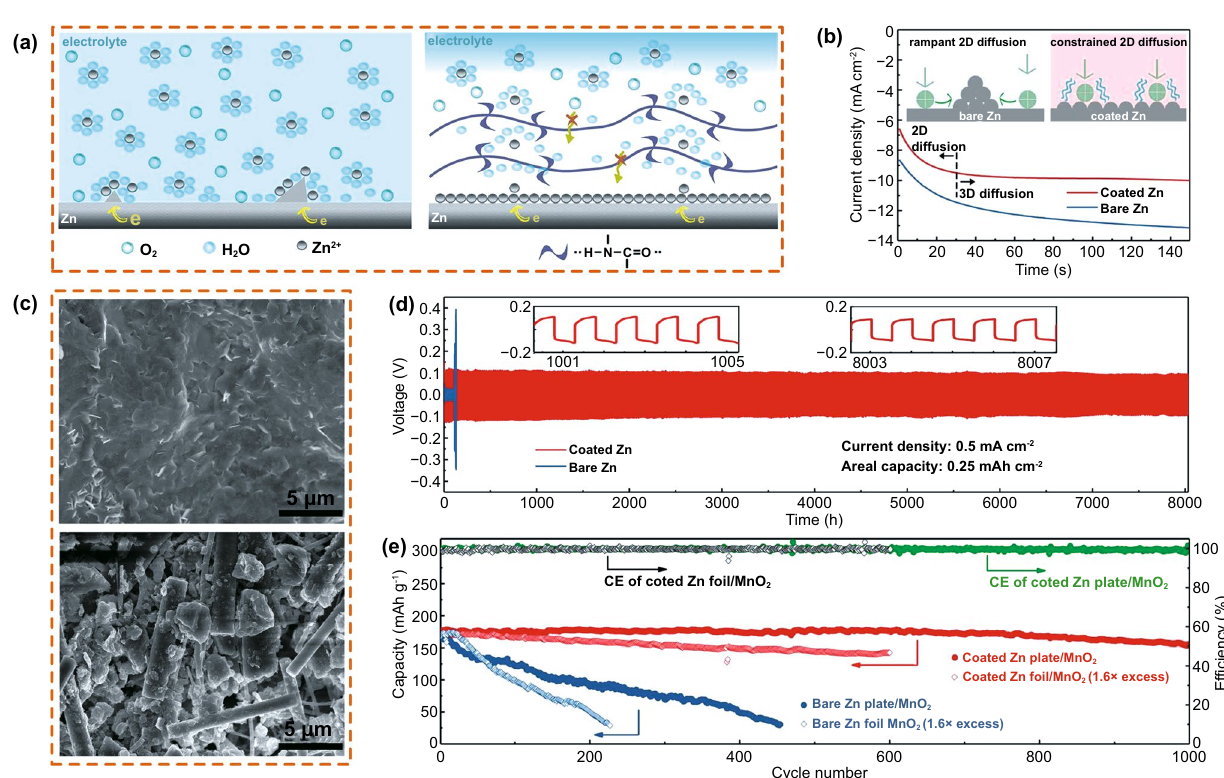
Fig. 10 a Schematic diagrams for Zn deposition on bare Zn and coated Zn. b Chronoamperograms of bare Zn and coated Zn at a -150 mV overpotential. Insets: schematics of the Zn 2+ diffusion and reduction processes on bare and coated Zn electrodes. c SEM images of the surface of a coated Zn plate anode after 1000 cycles and a bare Zn plate after 450 cycles. d Long-term galvanostatic cycling of symmetrical Zn cells with coated and bare Zn plates at 0.5 mA cm −2 . e Cycling performance at a current density of 2 C. Copyright 2019 Royal Society of Chemistry